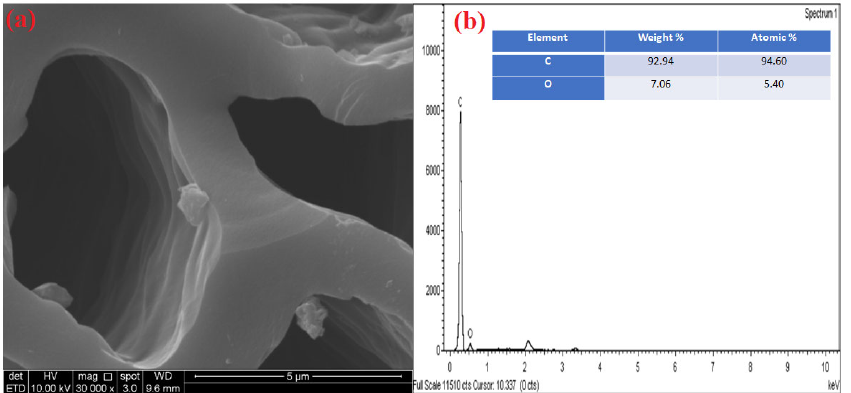
Figure 5. ( a ) SEM image of biochar and ( b ) EDX spectrum of biochar.